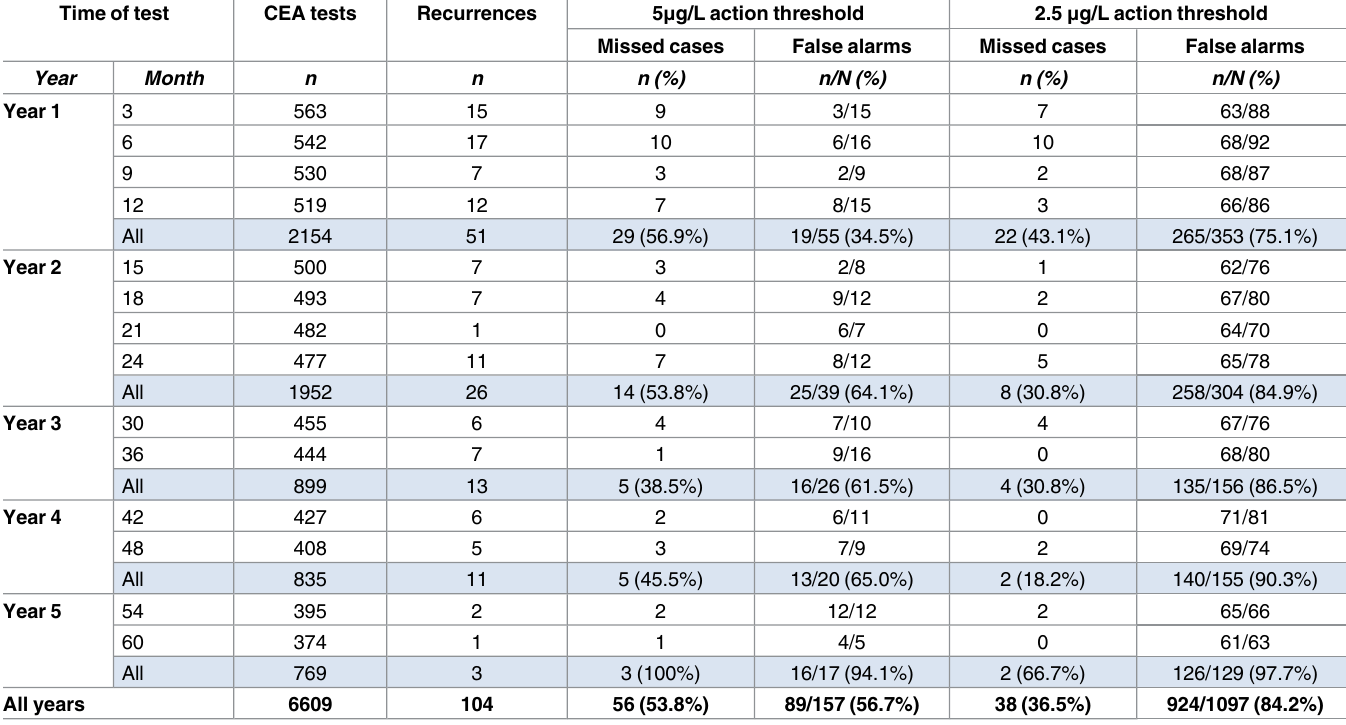
Table 2. Estimated operational performance of CEA in clinical practice at currently recommended intervals if further investigation is triggered by thresholds of 2.5 and 5 μ g/L. Time of